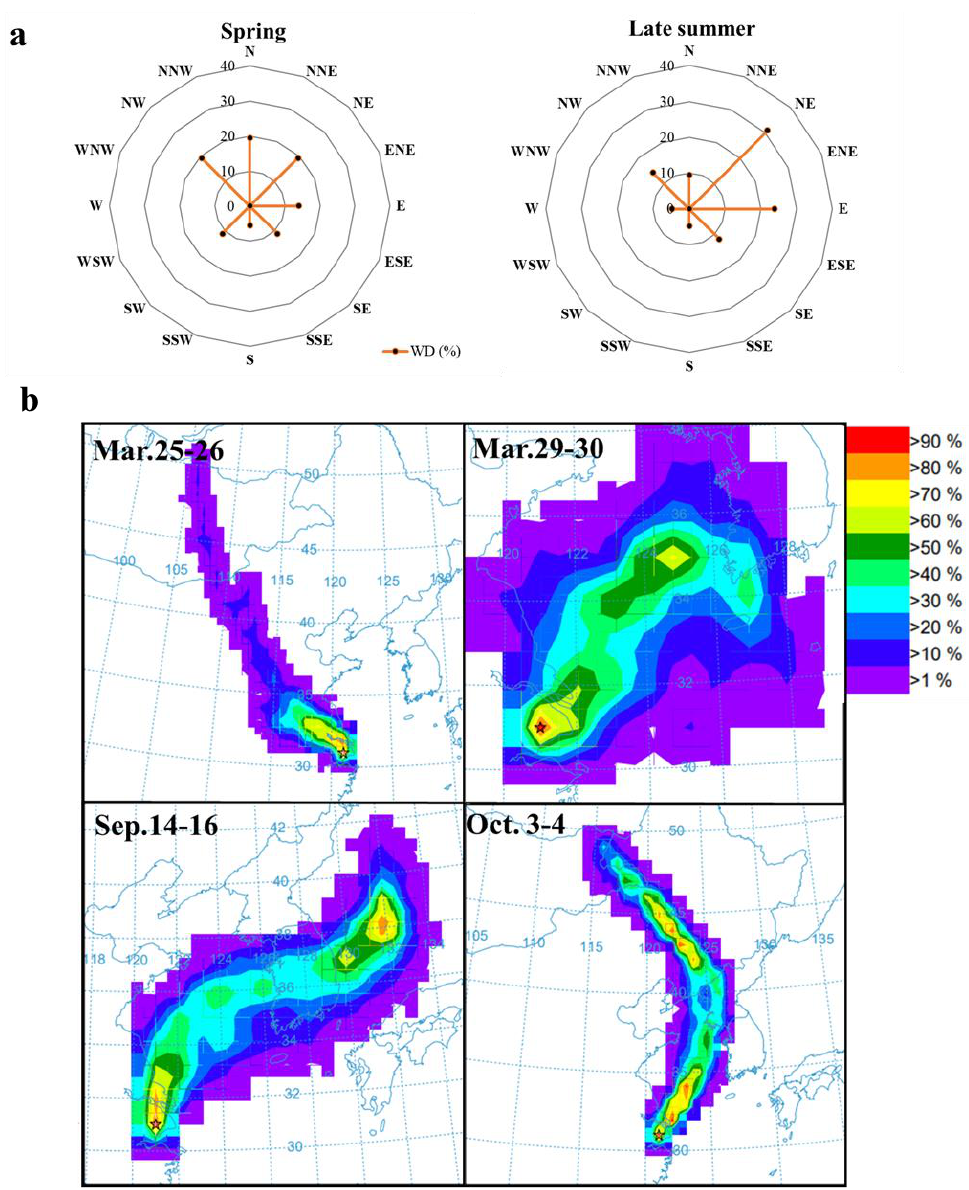
Figure 4. ( a ) Wind direction frequency (WD%) in the spring and late summer sampling periods (N: North; S: South; E: East; W: West); ( b ) air mass backward trajectories at the four sampling cases, 25–26 March; 29–30 March; 14–16 September; 3–4